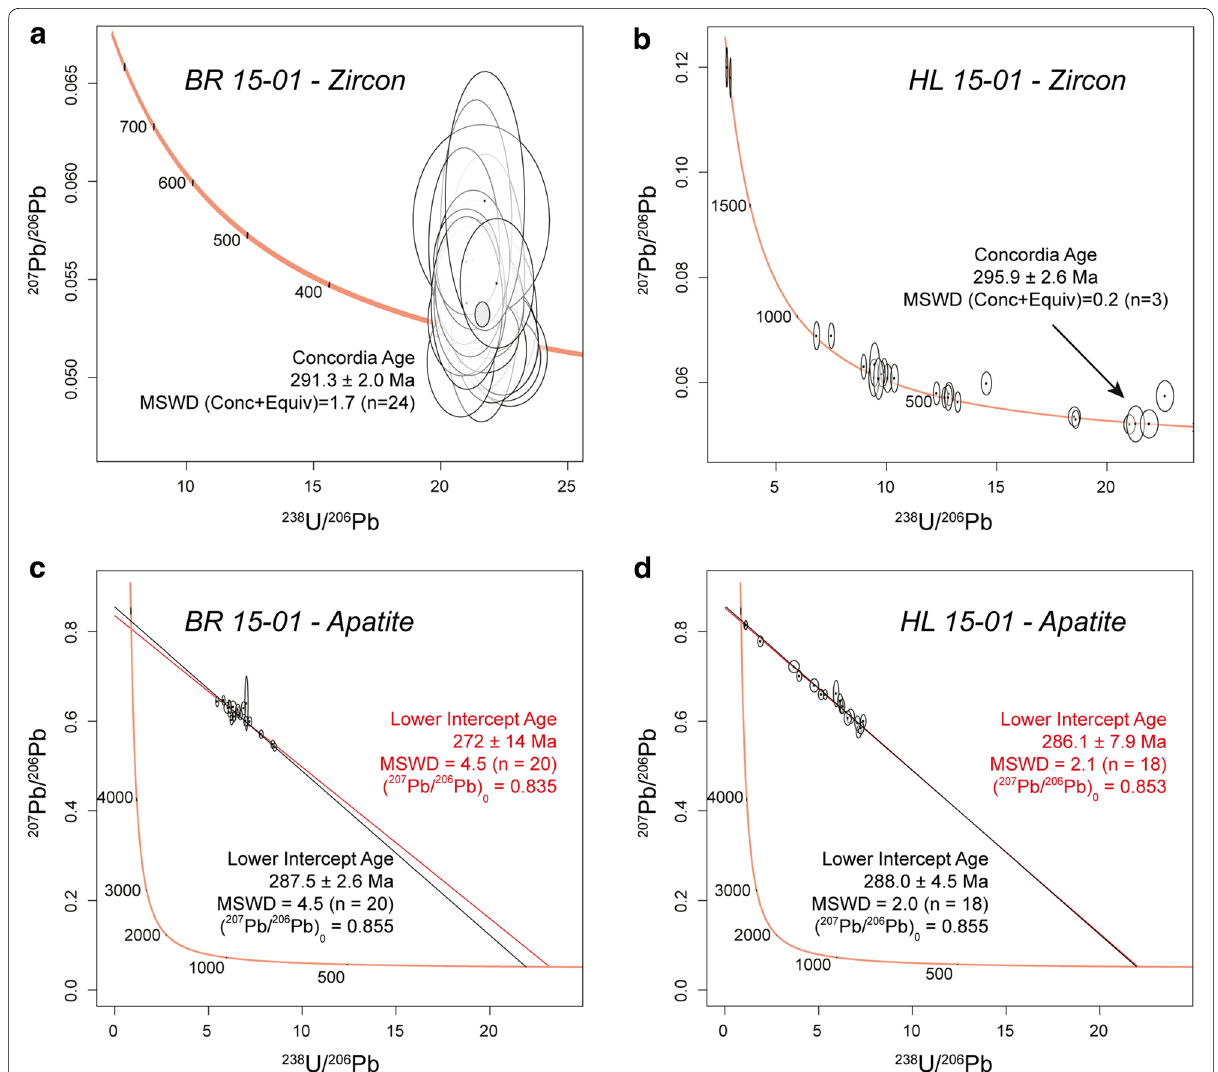
Fig. 7 a , b Tera-Wasserburg diagrams ( 207 Pb/ 206 Pb vs. 238 U/2 06 Pb) with the data obtained on zircon grains extracted from the Guil volcanics (sample BR 15-01) and the microdioritic sill (sample HL 15-01). c , d Tera-Wasserburg diagrams for the apatite grains from the same samples. The red discordia lines were obtained with a free regression of the data while the black discordia lines were obtained by forcing the regression to a ( 207 Pb/ 206 Pb) 0 value of 0.855 obtained using the Stacey and Kramers Pb evolution model (1975) for an age of ca. 295